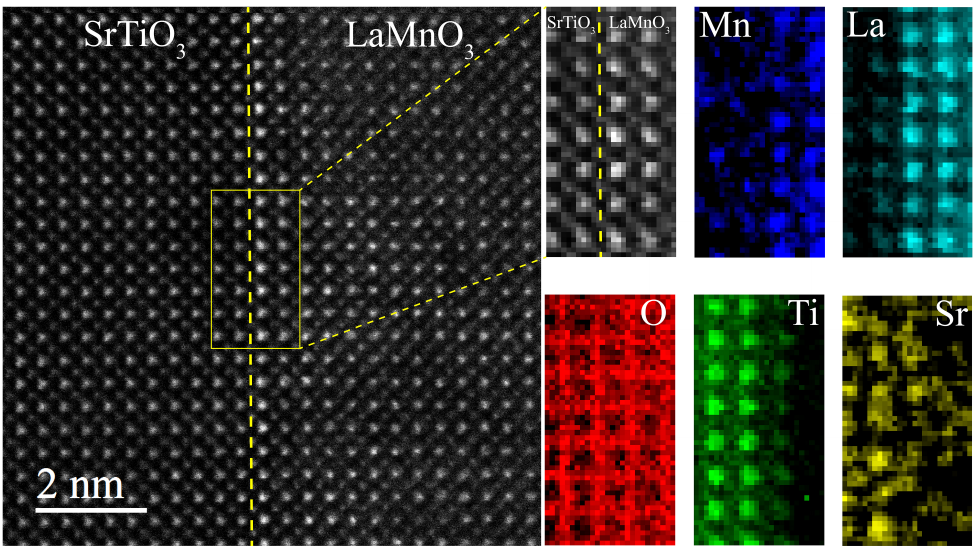
Figure 8. ADF − STEM images of the LaMnO 3 /SrTiO 3 heterostructure with selected area for core-loss EELS mapping (outlined by a yellow rectangle) and the resulting map showing the spatial distribution of Mn (blue), La (cyan), O (red), Ti (green) and Sr (yellow) atoms.